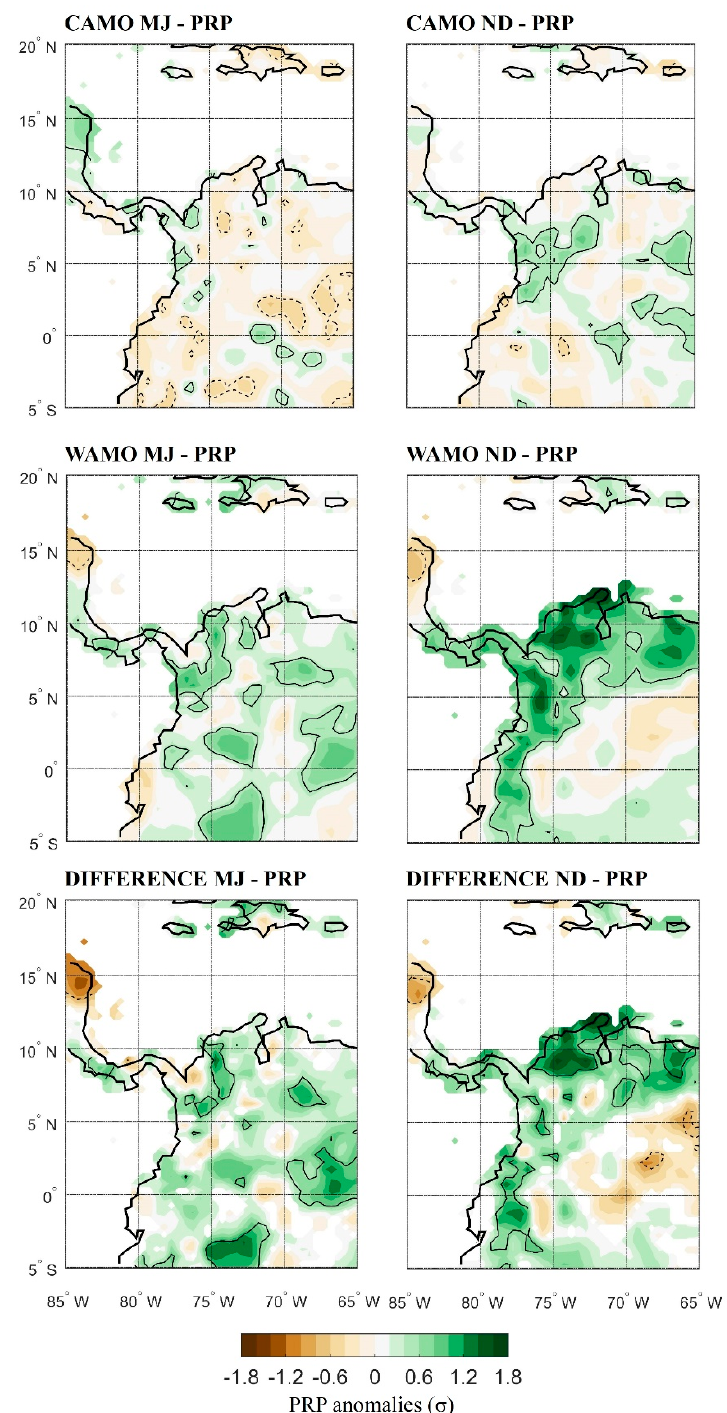
Figure A2. Patterns of standardized precipitation anomalies associated with extreme flow events at Bellavista in May–June (MJ in left column), and November–December (ND in right column), (CAMO (upper line), WAMO (middle line) and difference (WAMO minus CAMO) (lower line)). The contour range is 0.2 standard deviation. The continuous line (dashed) refers to significant positive (negative) values at a 95% confidence level. The data were acquired from the Global Precipitation Climatology Centre (GPCC 2019) Full Data Reanalysis V2018, at a horizontal spatial resolution of 0.5° × 0.5° [100]. Standardized monthly anomalies were calculated using historical data for the 1965–2015 period.